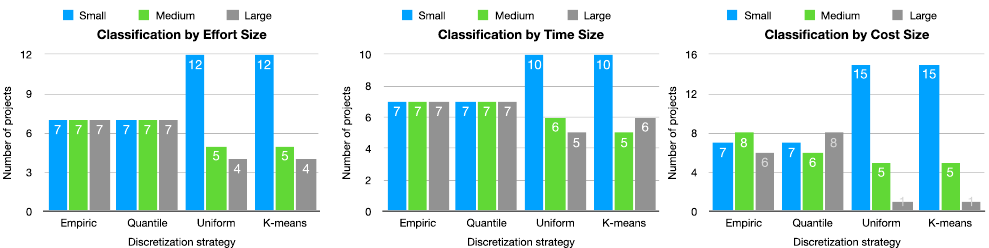
Figure 8. Discretization using different strategies, where empirical method gave similar results to